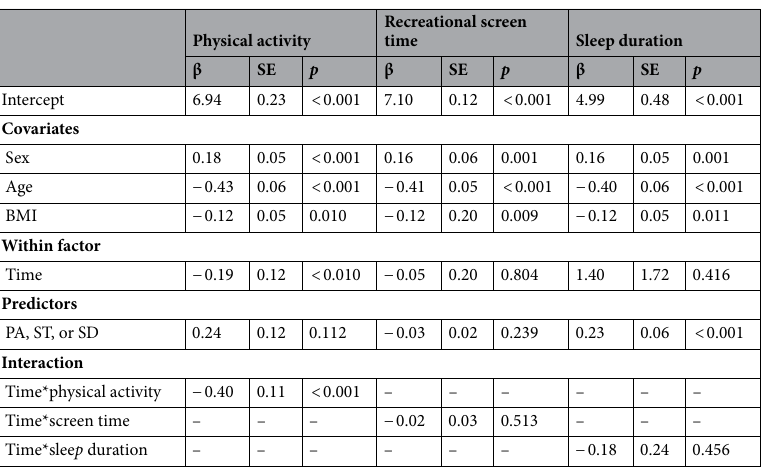
Table 2. Mixed models analysing the association between 24-Hour Movement Behaviours (physical activity, recreational screen time, and sleep duration) and academic performance before (T1) and 1-year after (T2) into the Covid-19 pandemic. The reported β values are standardized coefficients. BMI Body Mass Index; PA Physical activity; ST Screen time; SD Sleep duration. Intercept = Academic performance before Covid-19 lockdown; Time: -1 = March to June 2018 and 1 = February to March 2021; Predictors = Slope before Covid-19 lockdown; Interaction = Slope before Covid-19 lockdown versus slope 1-year after Covid-19 pandemic.